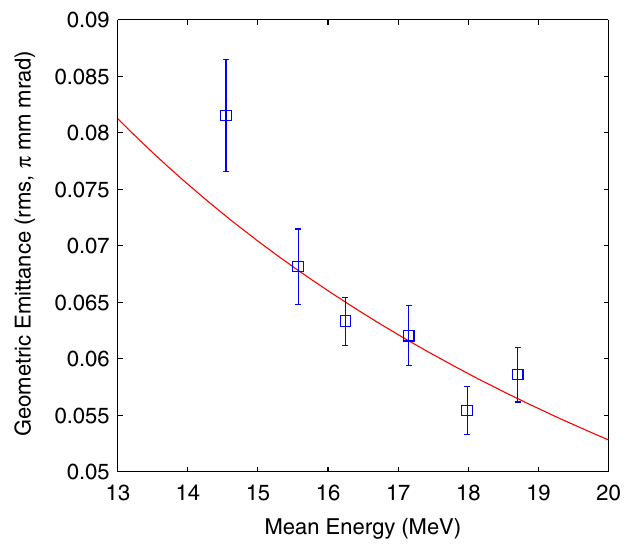
FIG. 3. Variation of the geometric emittance versus mean energy of the electrons. Error bars indicate the standard devia- tion of the mean for each binned set of data. The data follow a 1 =(cid:5) curve (red line) consistent with a constant normalized emittance of 2 : 3 (cid:3) 17% (cid:2) mm mrad from the laser wakefield acceleration for all shots.